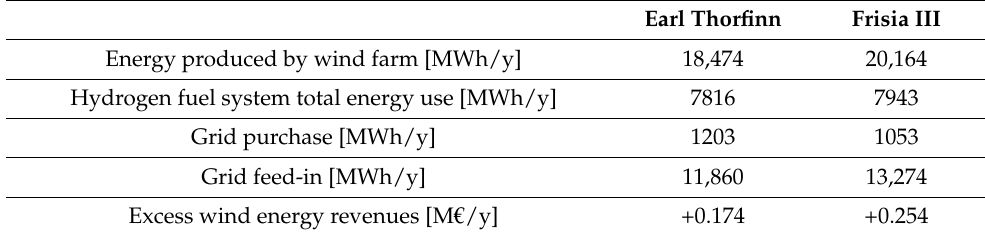
Table 5. Wind farm energy production versus actual fuel system energy use and resulting excess energy balance.